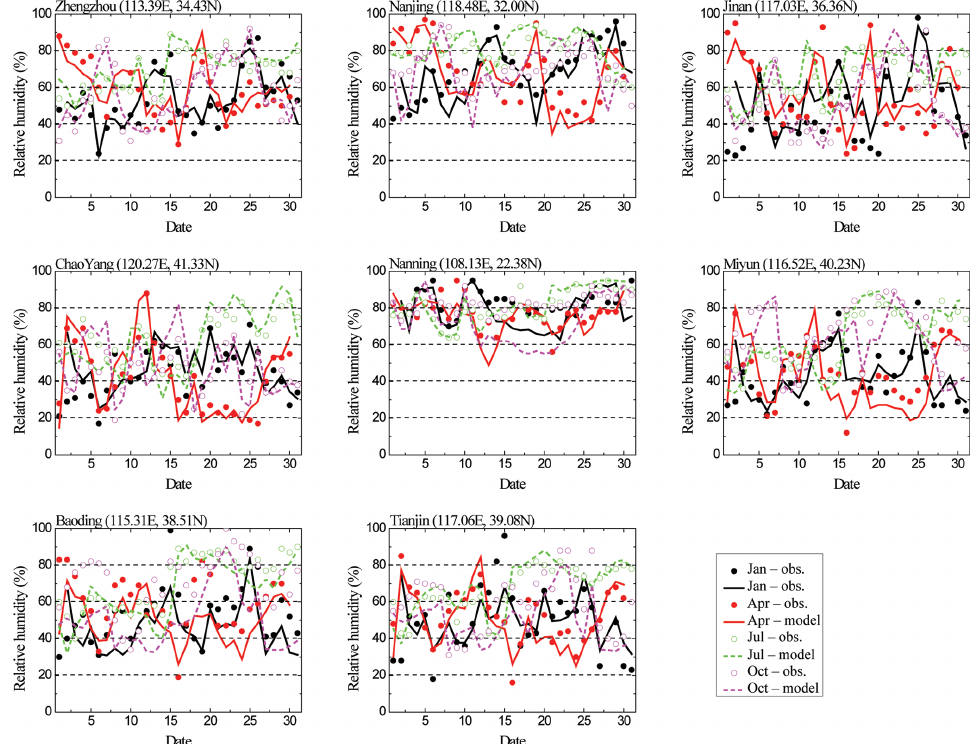
Figure A2. Same as Fig. A1 but for relative humidity